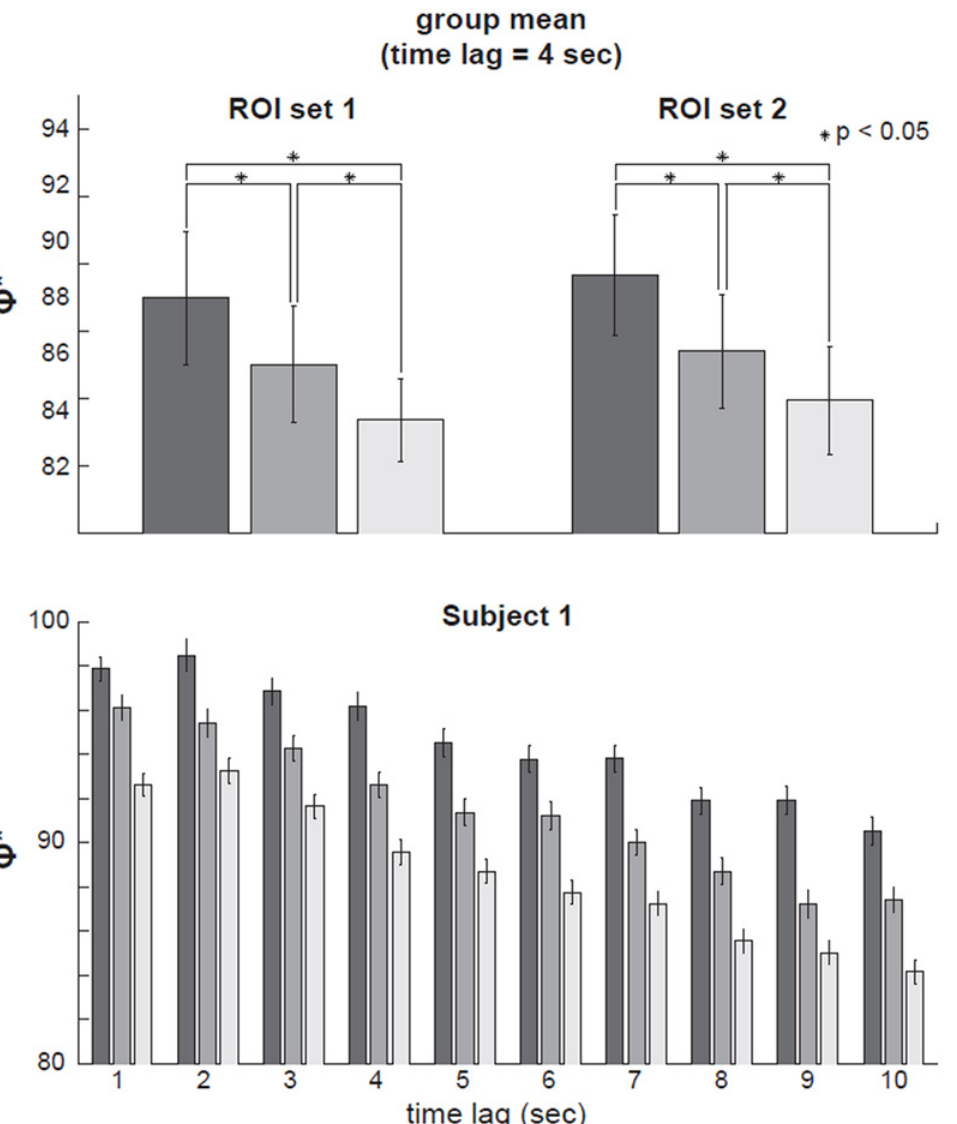
Fig 7. Group results for Integrated information Φ * analyses. Integrated information Φ * results for the movie, scrambled movie, and ‘ TV noise ’ conditions. Colors of bars represent conditions (dark gray: movie, medium gray: scrambled movie, light gray: TV noise). Upper left panel: the group-mean of Φ * calculated by using time lag of 4 second and ROI set 1. Error bar represents standard error of the mean for each measure in each condition. Asterisks indicate significant differences of the group means (p < 0.05, corrected). Upper right panel: the group-mean of Φ * calculated by using time lag of 4 second and ROI set 2. Lower panel: Φ * calculated in our representative subject with ROI set 1, showing robust results across different time lags (1 – 10 seconds). In this panel, error bar indicates standard deviation of the mean for 1000 sets of 80 ROIs (see Methods).